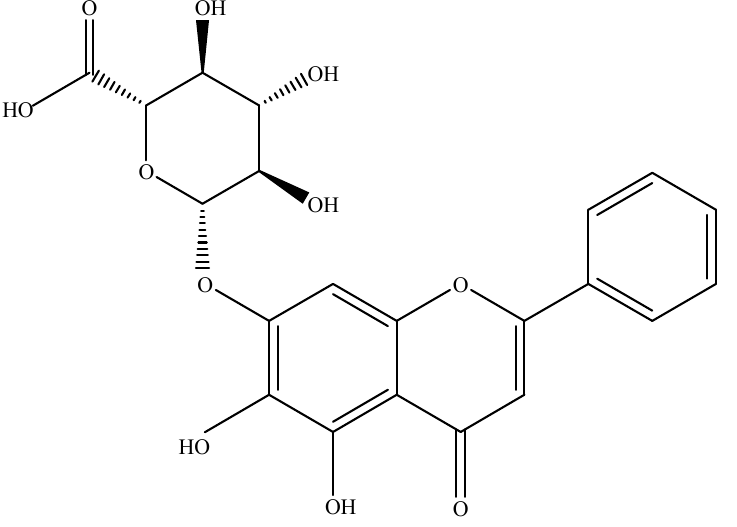
Figure 1. The chemical structure of baicalin.